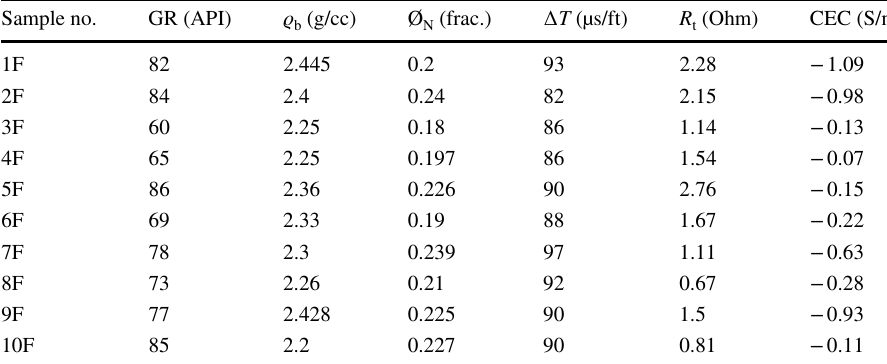
Table 4 Log readings against cation exchange capacity samples